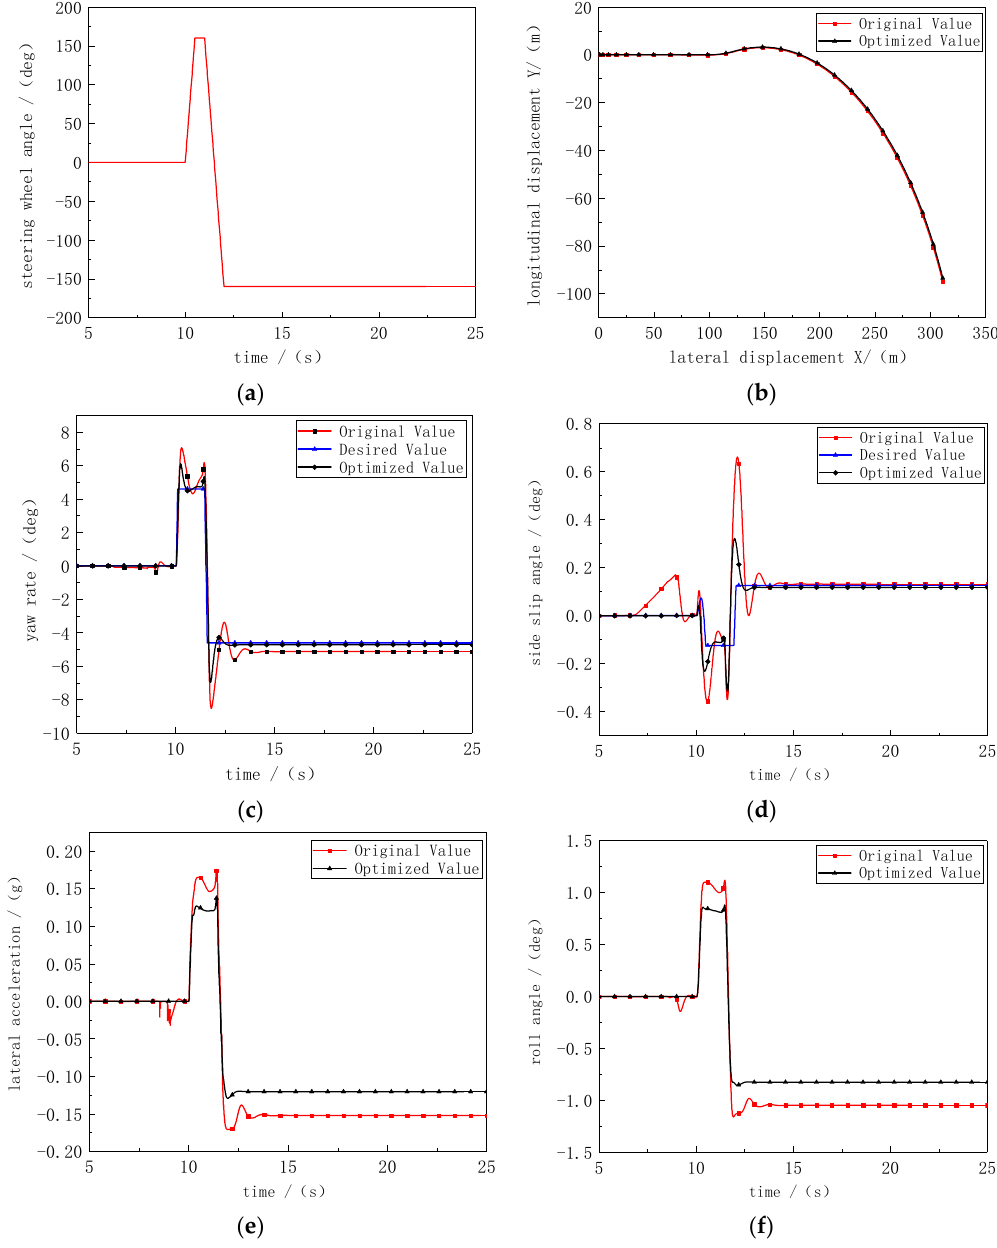
Figure 7. Simulation results of fish hook test condition. ( a ) Steering wheel angle. ( b ) Vehicle track. ( c ) Yaw rate. ( d ) Side slip angle. ( e ) Lateral acceleration. ( f ) Roll angle.